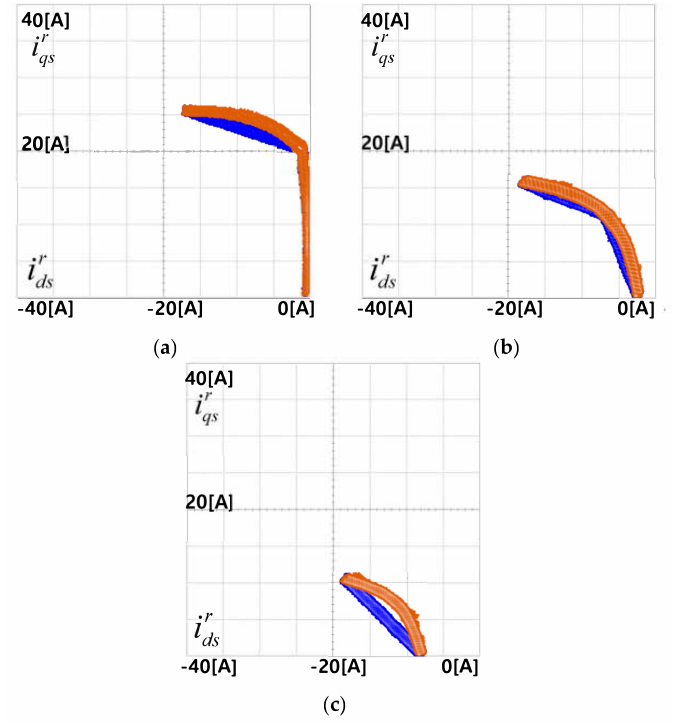
Figure 9. Comparison of experimental results of the conventional and the proposed method with and without 2D interpolation compensation. ( a ) Operation at 750 rpm, ( b ) operation at 1150 rpm, ( c ) operation at 1500 rpm.